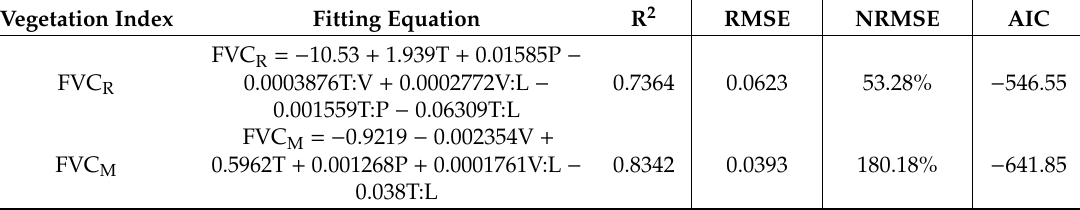
Table 3. The optimal fitting model between FVC and meteorological factors.